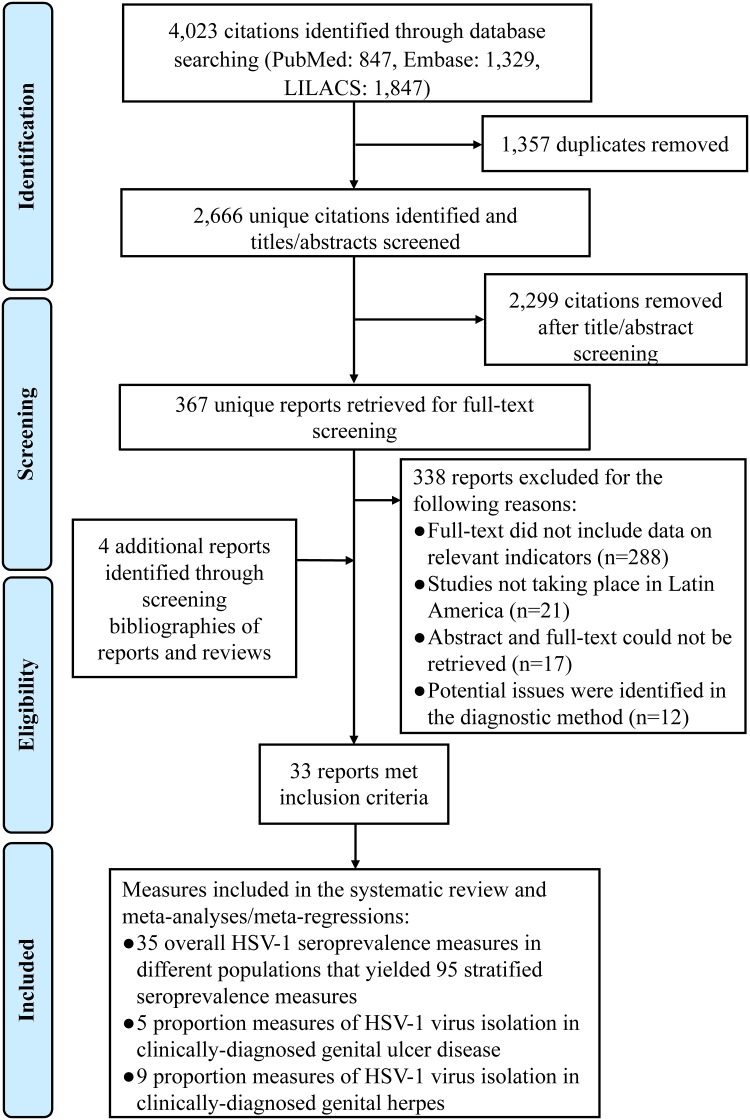
Flow chart of article selection for the systematic review of HSV-1 infection in Latin America and the Caribbean, per the PRISMA guidelines [15].Abbreviation: HSV-1 = Herpes simplex virus type 1.